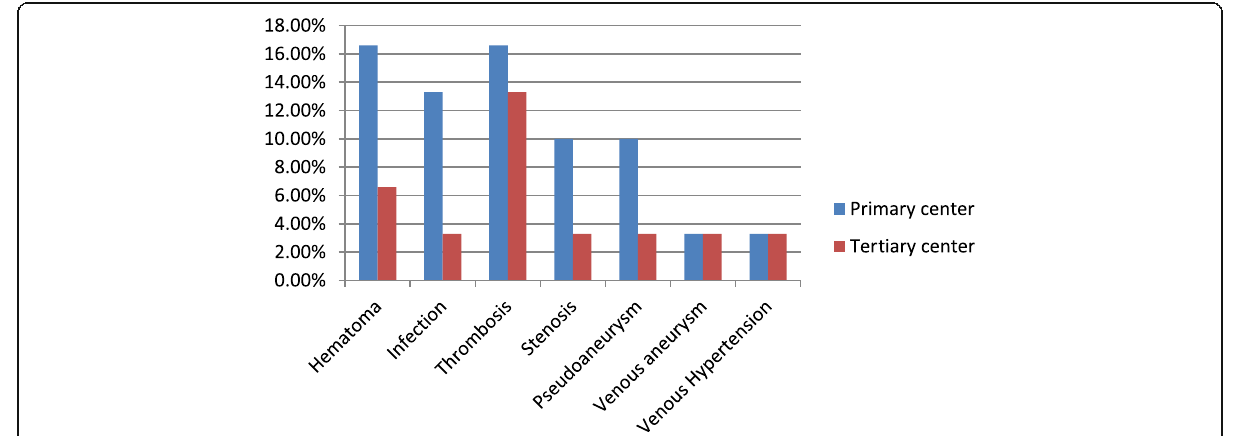
Fig. 7 Frequency of AVF complications among the included patients referred from primary and tertiary